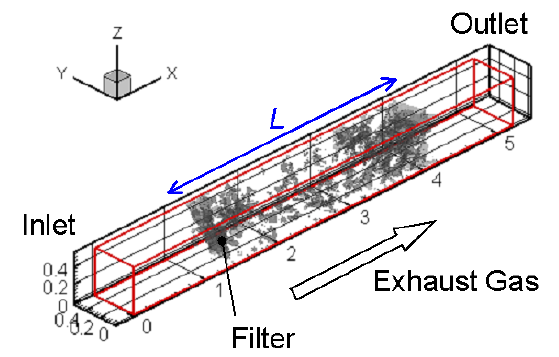
Figure 4. The calculation domain and coordinate system are